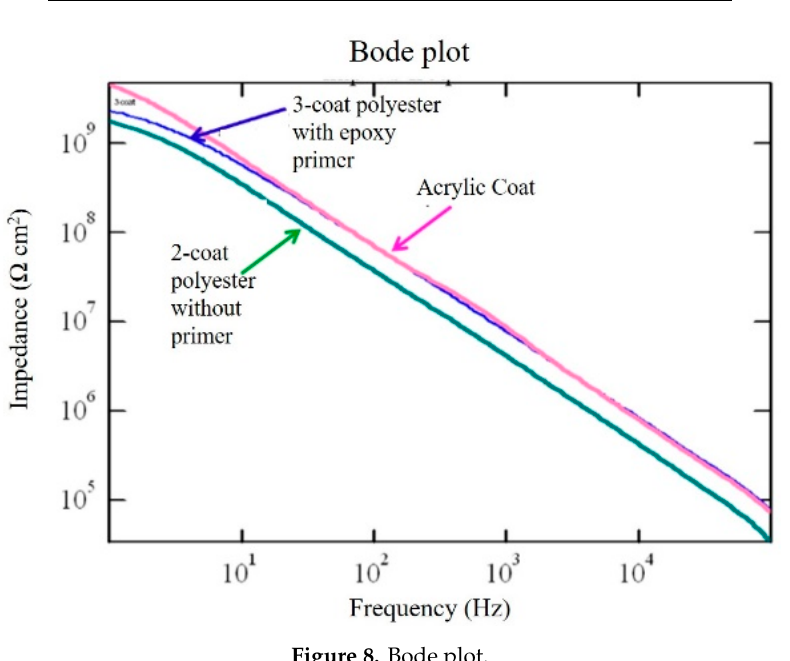
Figure 8. Bode plot. Table 3. Electrochemical impedance spectroscopy results.